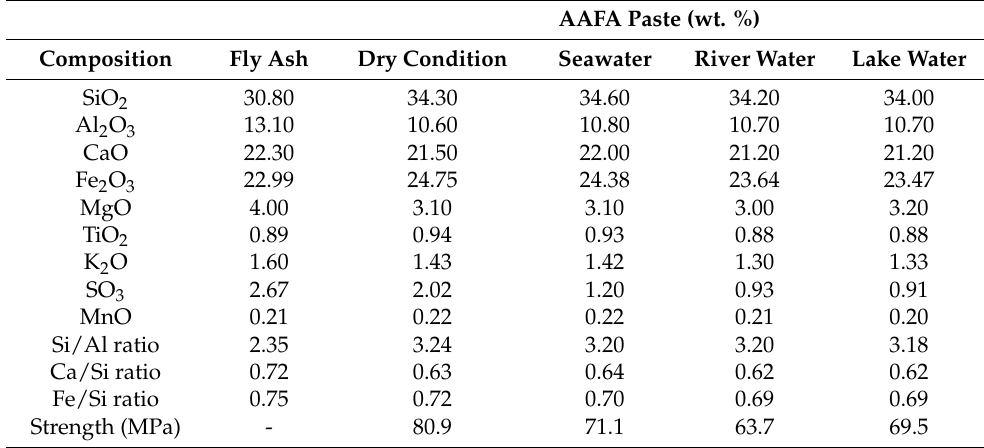
Table 3. Comparison of chemical composition for all